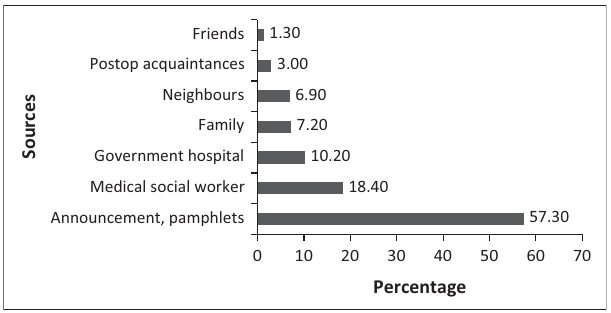
FIGURE 1: Source of information on cataract surgery in camp. TABLE 2: Barriers to cataract surgery uptake. Reasons for not taking up cataract surgery